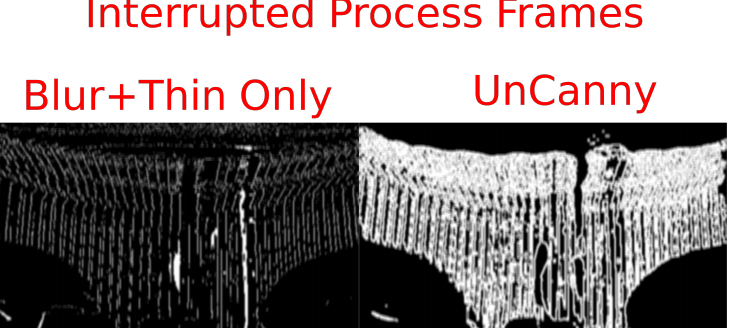
Figure 7. The cause of the previous incorrect detection by the UnCanny filter can be seen by observing an intermediate frame from the computer vision process. Depicted are the steps of the simplified “Blur + Thin Only” method and the UnCanny method prior to applying the edge thinning step. The Sobel edge detection step, only present in the UnCanny method, has made the strikers appear far more intense. This over-intensity due to minute vibrations was propagated to the final reported image.